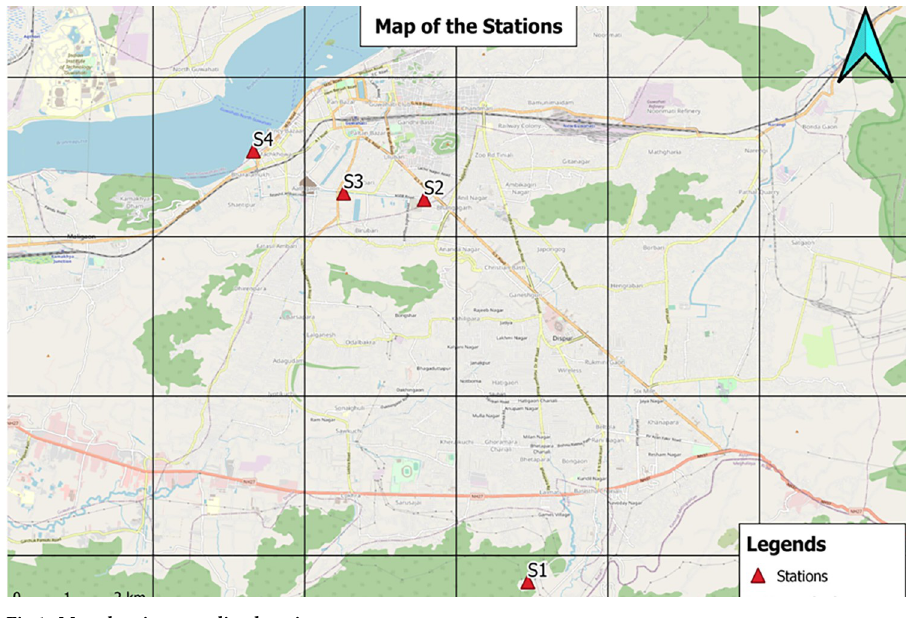
Fig 1. Map showing sampling